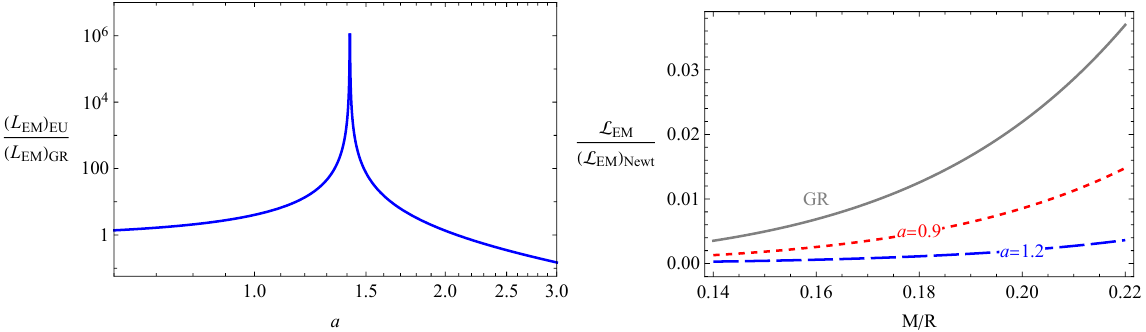
Figure 10. Plasma magnetospheric radiation luminosity in EU normalized to its GR value as a function of the EU parameter a (left panel) and the compactness (cid:101) (right